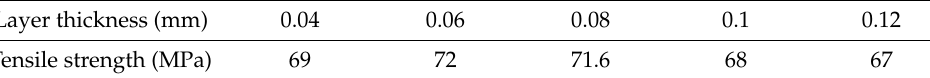
Table 3. Tensile strength vs. layer thickness.